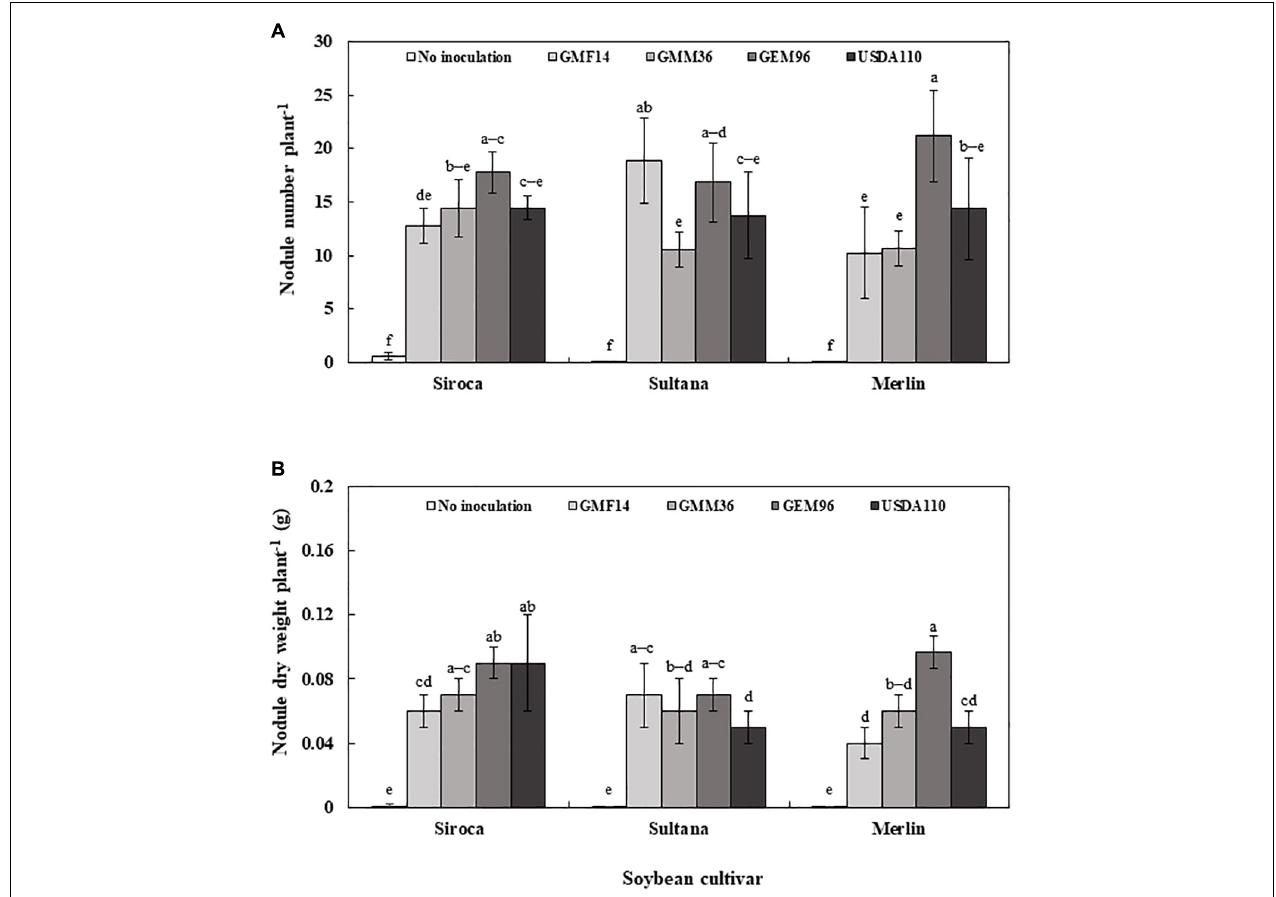
FIGURE 6 | Nodule number (A) and Nodule dry weight (B) of three soybean culuVars inoculated with different Bradyrhizobium strains in field conditions. The error bars are standard deviation of six replications ( n = 6). Values followed by the same letters on each bar are not significantly different at p ≤ 0.05.